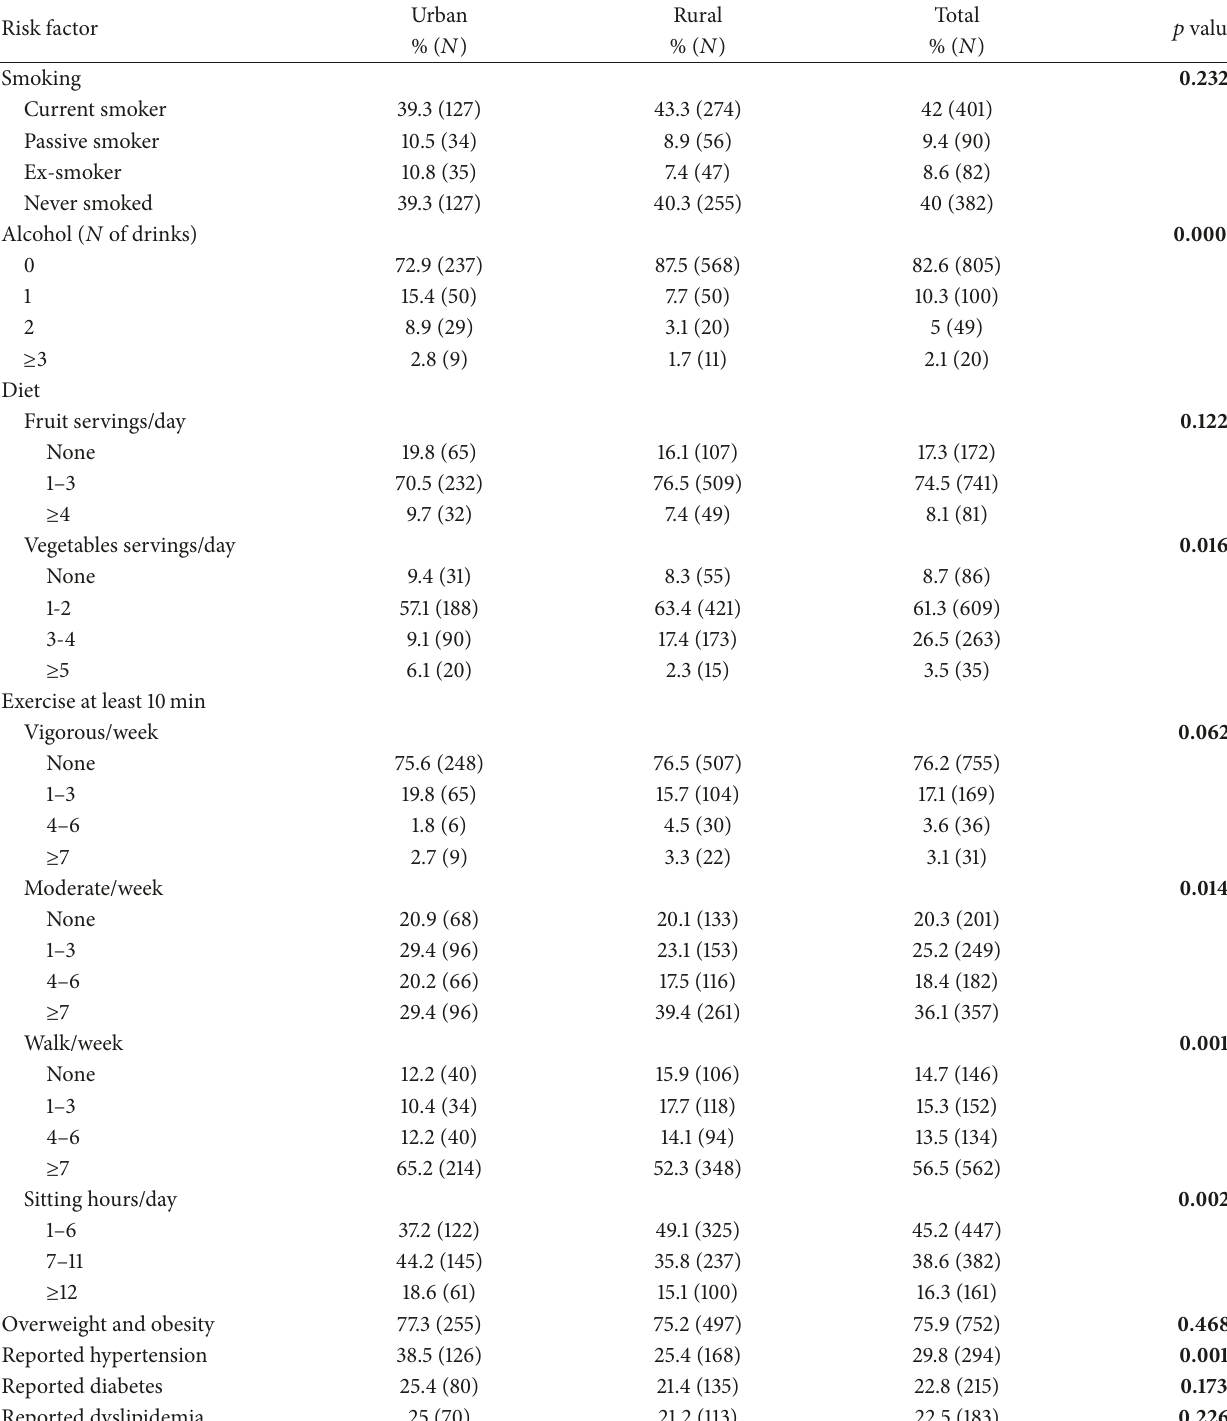
Table 2: Prevalence of modifiable cardiovascular risk factors among the study